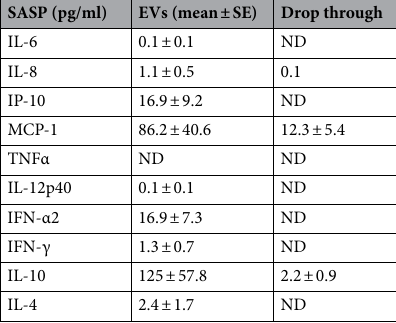
Table 2. Urine SASP mediators in EVs derived from young adults. Data presented are calculated from 10 normal young adults. SASP senescence associated secretory phenotypes, SE standard error, ND not detectable.